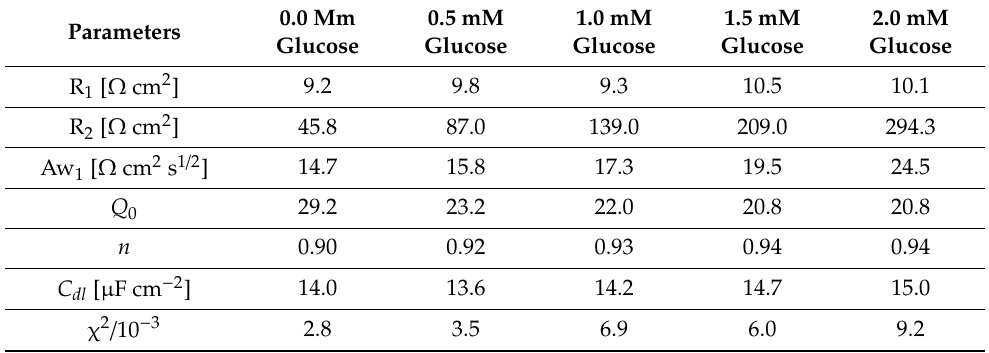
Table 3. Equivalent circuit parameters obtained from fitting procedure applied to EIS spectra recorded in sPBS (see Figure 7b).